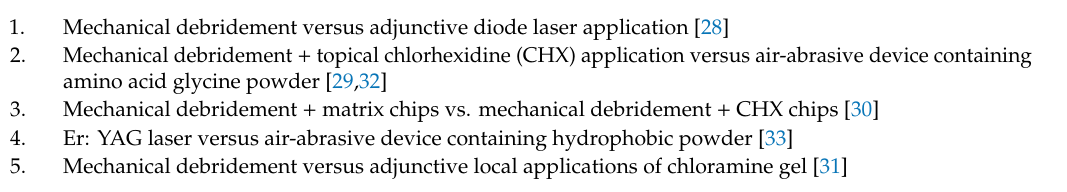
Table 4. Non-surgical treatment